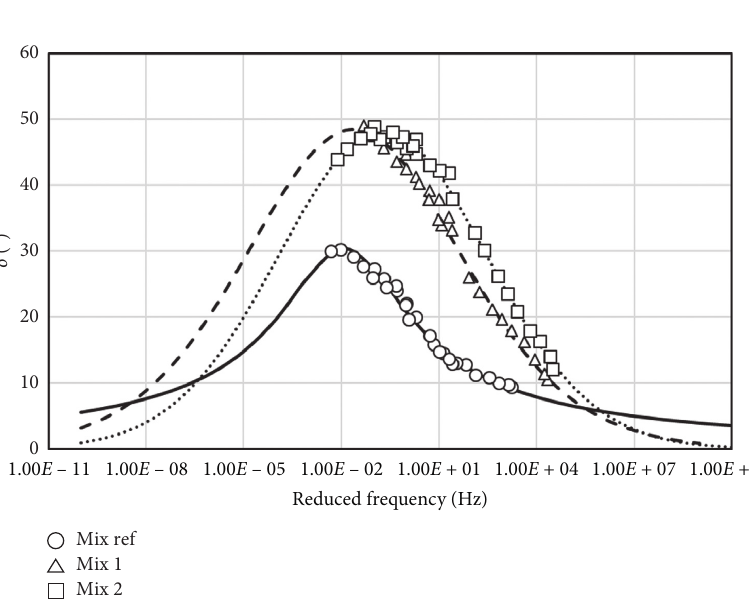
Figure 8: Phase angle master